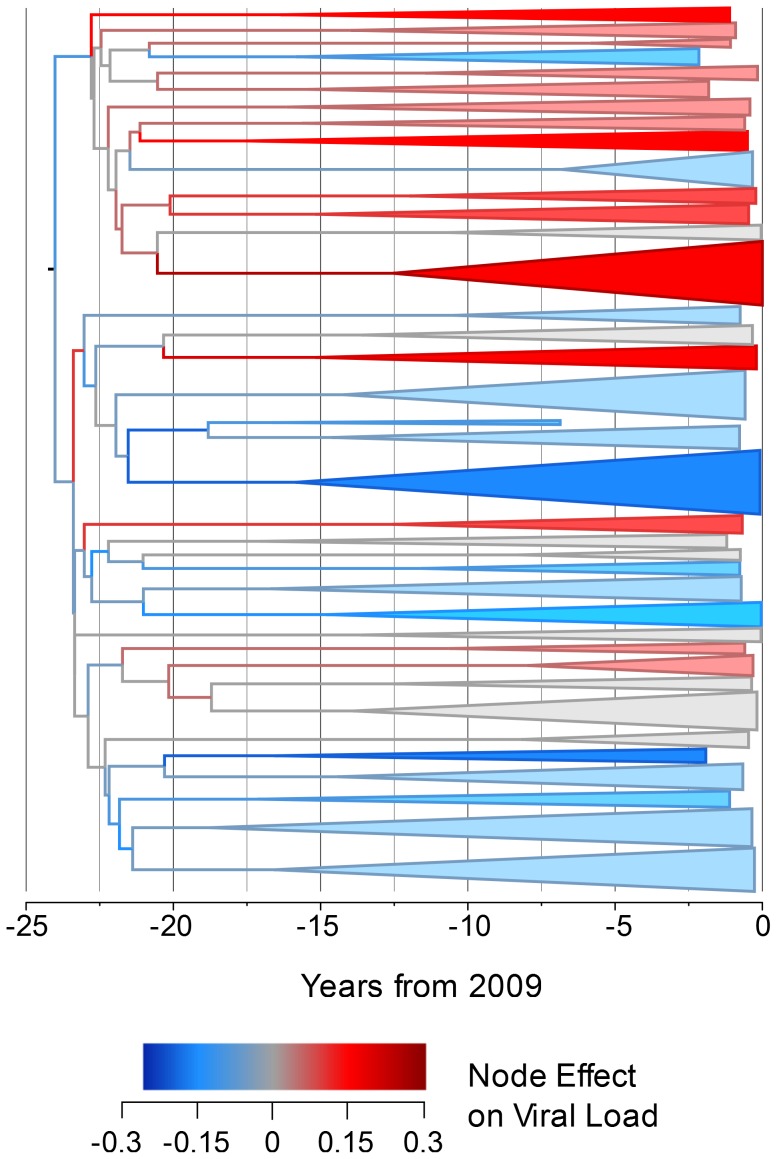
The estimated node effect plotted onto the phylogeny.The estimated phylogenetic effect of each node on log10 viral load plotted back onto the phylogeny from the 652-sample BEAST analysis. The axis shows the time in years from the most recent sequence, which was taken in 2009. Branches have been colored by the scale of the effect. Clusters of branches have been collapsed to improve readability, and are colored by the average tip effect within each cluster. As the number of bifurcations in the tree reduces at around 17.5 years before 2009, this used as the threshold for collapsing. Nodes that have a similar effect on viral load cluster together, as expected if some of the variation in viral load is heritable.